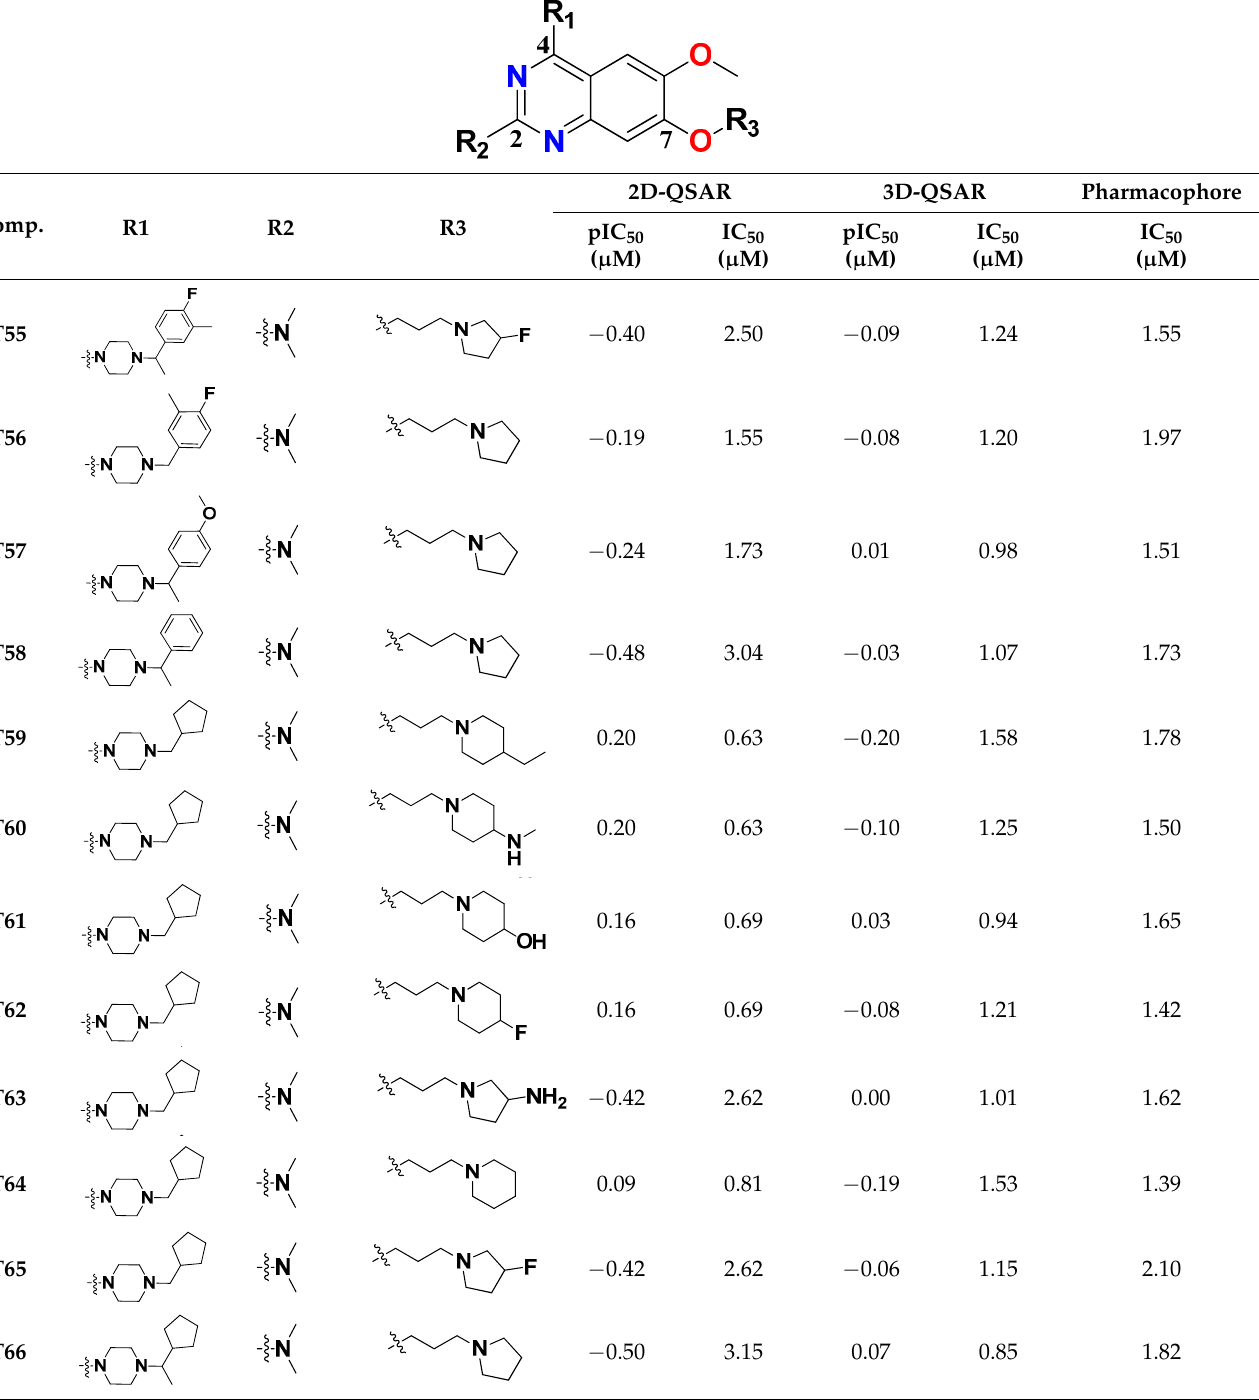
Table 4. Structures of newly designed molecules and their predicted activities based on 2D and 3D-QSAR models.